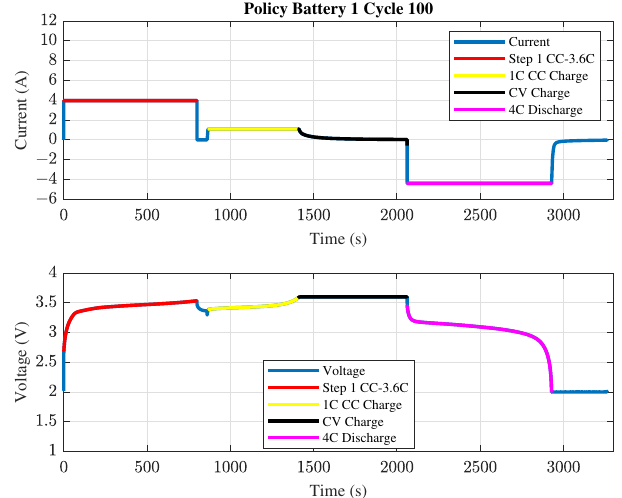
Figure 2. Example of full charge and discharge cycle for battery #1 of the